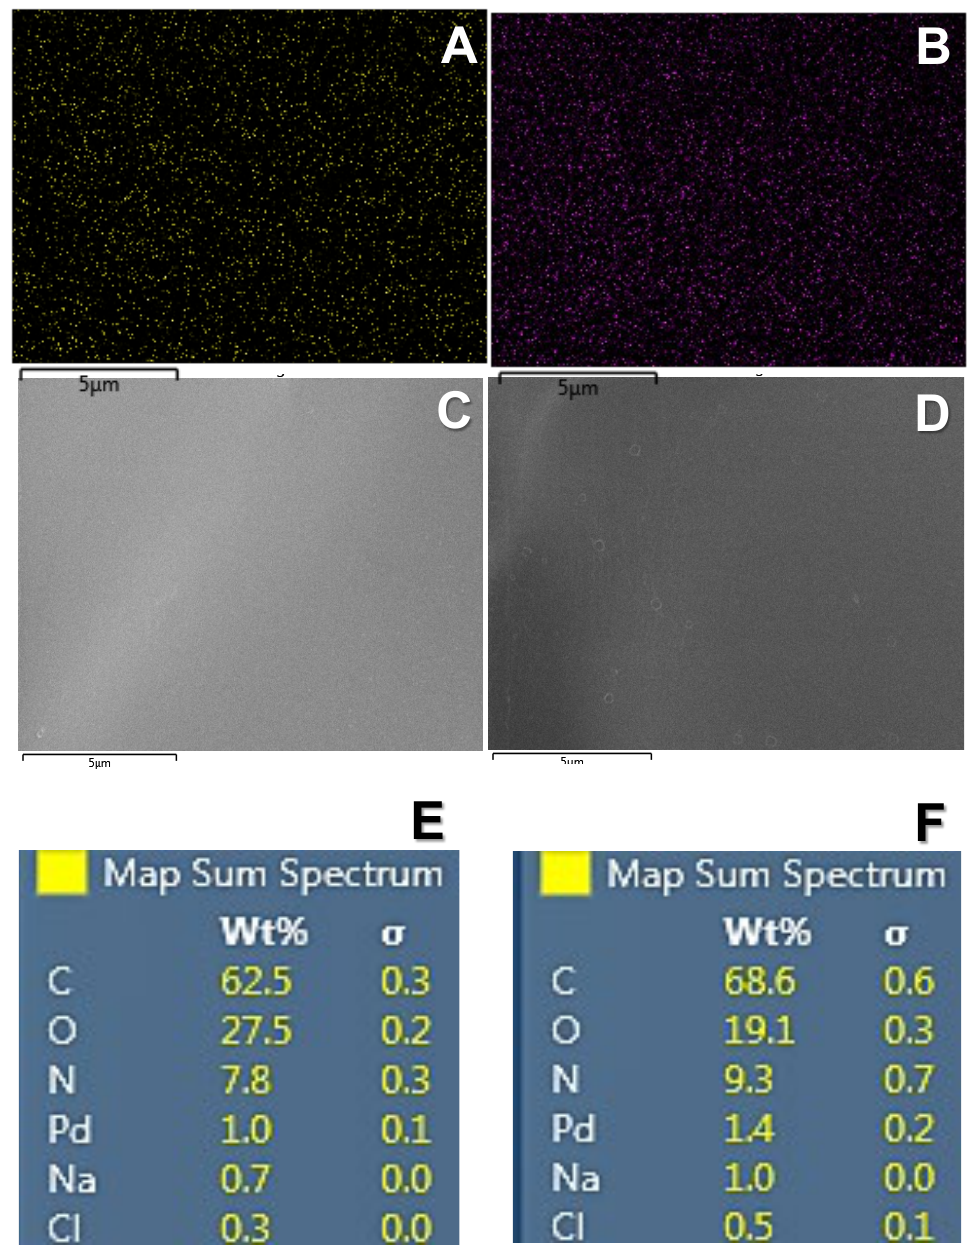
Figure 5. Energy-dispersive X-ray spectroscopy analysis of CHI-GA-PdNPs cryogel containing 0.8 mM PdNPs ( A , C , E ) and 1 mM PdNPs ( B , D , F ). Dots represent PdNPs ( A , B ).